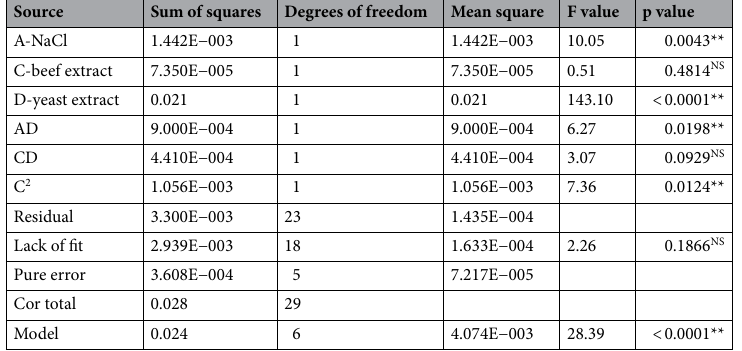
Table 4. ANOVA for response surface reduced quadratic model with backward elimination regression. * p > 0.05, **p > 0.01, NS non-significant. Non-significant terms removed via backward regression alpha to exit = 0.100. R 2 = 0.8811, Adj-R 2 = 0.8500, Pred-R 2 =